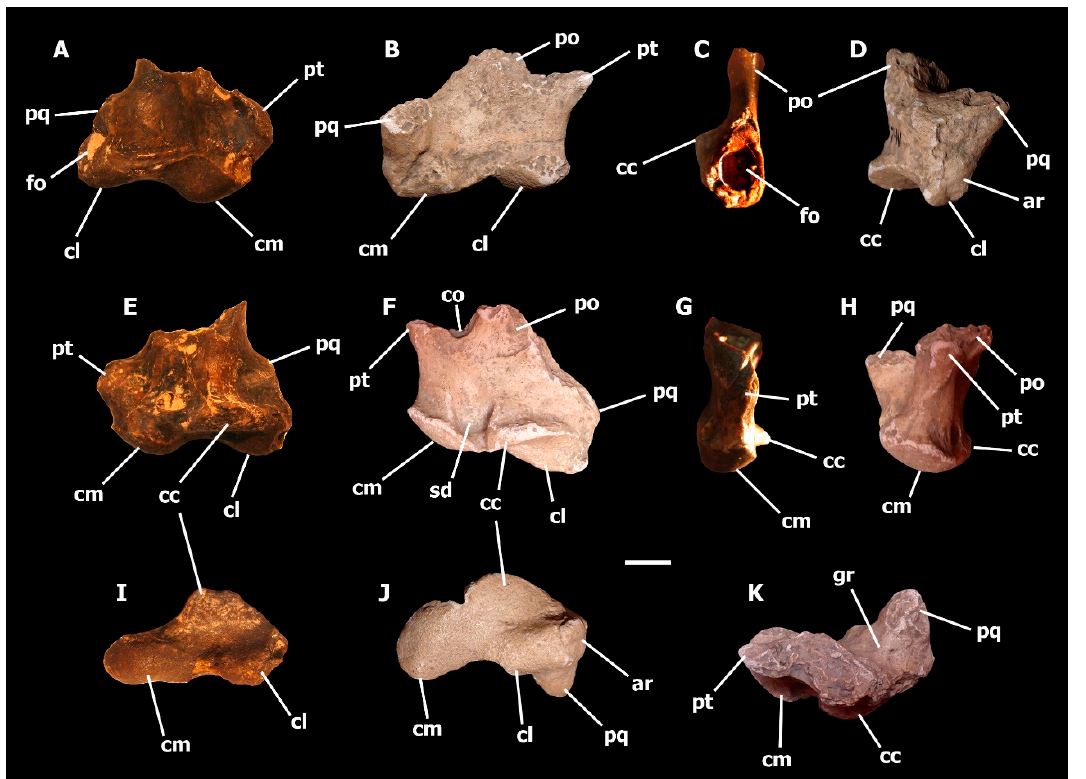
Figure 6. Comparisons between the quadrate referred to Brontornis burmeisteri ( B , D , F , H , J , K ; plaster copy of MLP 20-111) and the phorusrhacid Patagorhacos terrificus ( A , C , E , G , I ) in ( A , B ) anterior; ( C , D ) lateral; ( E , F ) posterior; ( G , H ) medial; ( I , J ) distal; and ( K ) proximal views. Abbreviations . ar, extended articular surface; cc, caudal condyle; cl, lateral condyle; cm, medial condyle; co, concave surface separating the pterygoid and orbital processes; fo, quadratojugal fossa or fovea; gr, wide groove separating the quadratojugal process and the orbital process; po, orbital process; pq, quadratojugal process; pt, pterygoid process; sd, supracondylar depression or fossa. Scale bar: 2 cm for B,D,F,H,J,K; 1 cm for A,C,E,G,I.